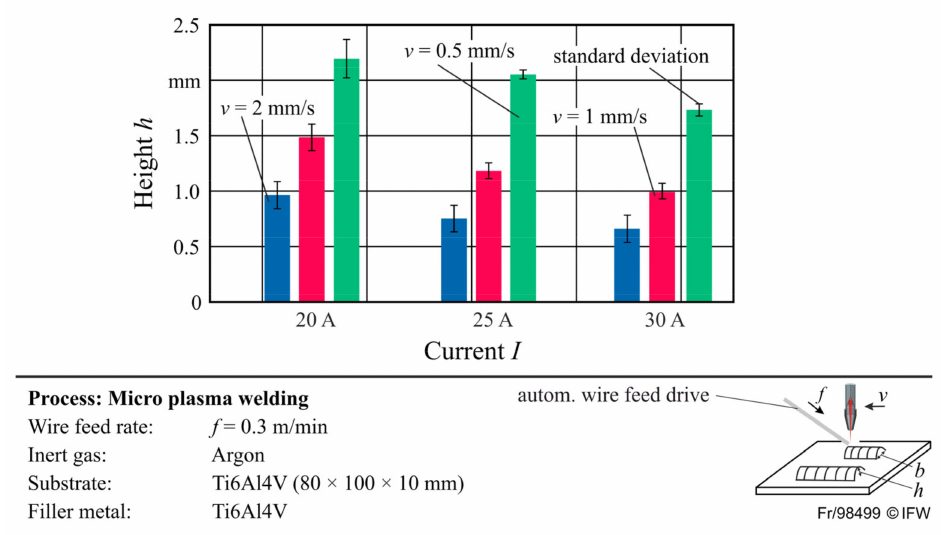
Figure 7. Measured height and standard deviation for different travel velocity and